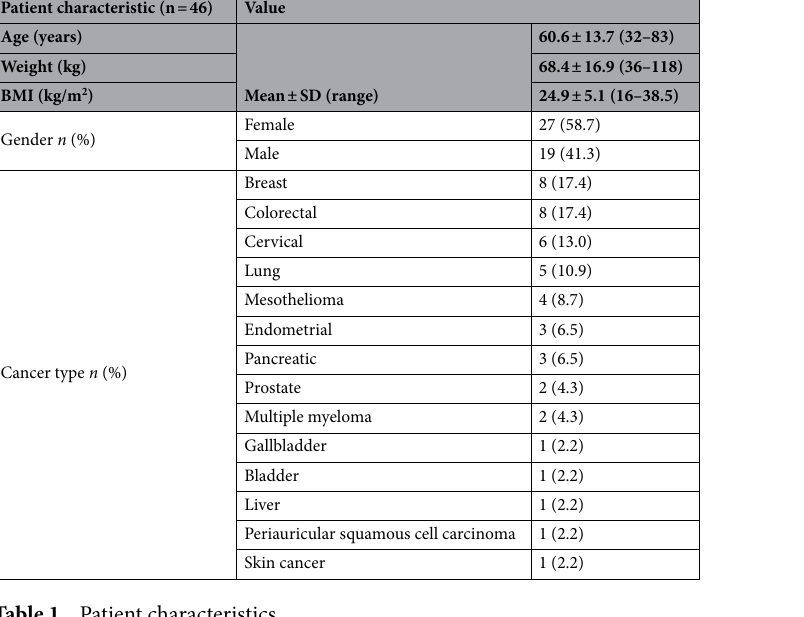
Table 1. Patient